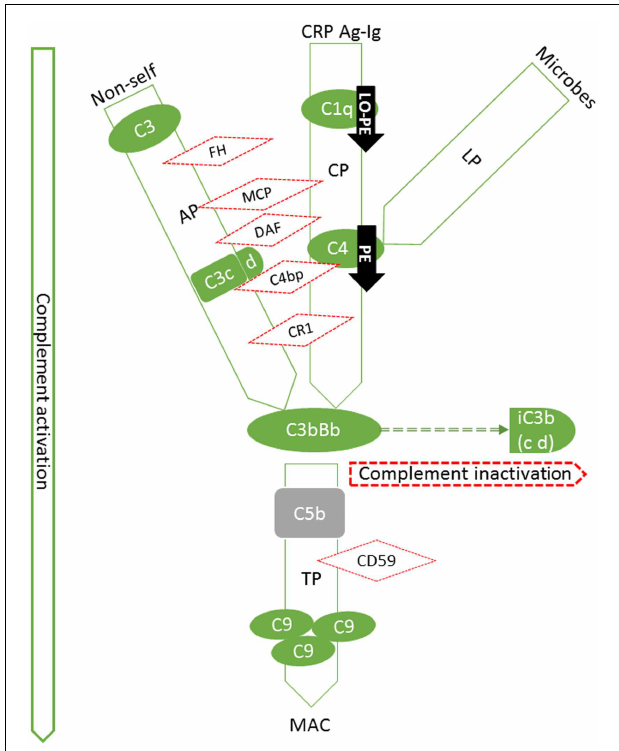
FIGURE 3 | Summary of expression patterns of complement components in the placenta . Our findings are highlighted in black arrows (PE: preeclampsia, LO-PE: late-onset preeclampsia). Pictured are the components that we studied in their respective position in the activation cascade (green solid lines and shapes) or regulatory network (red dotted lines and shapes).The C system is composed of approximately 20 plasma proteins, which can be activated in a stepwise cascade via the classical (CP, via Ag-Ig: immunocomplexes or CRP: C-reactive protein), lectin (LP), or the alternative pathway (AP). In addition, there are approximately 15 components that act as receptors or protective molecules on cell membranes. All three pathways result in the activation of the main complement component C3 and thereafter of the terminal pathway causing the formation of membrane attack complexes (MACs) and ultimately target cell damage. C5b (not studied, in gray) is the activated component at the onset of terminal pathway. FH is a regulator of the alternative pathway, where its main role is to act as a cofactor for Factor I in the cleavage of C3b into iC3b. Similarly in the classical pathway, cleavage of C4 to activated form C4b is inhibited by a potent regulator C4bp. C3b and C4b are both generated by activation of not only the classical, but of the lectin pathway as well. C1q is a potent activator of the classical pathway. Binding of the complex (C1qr 2 s 2 ) activates the C4 step.Together with decay accelerating factor (DAF; CD55) and membrane cofactor protein (MCP, CD46), C4bp regulates the progression of the classical C pathway by controlling the formation and function of the classical pathway C3 convertase, C4b2a. Like FH, MCP can also act as a cofactor in C3b inactivation. In the classical pathway, DAF accelerates the disassembly of C4b2a and in the alternative pathway that of C3bBb. DAF is a glycosylphosphatidylinositol-anchored membrane molecule. Complement receptor type 1(CR1, CD35) is